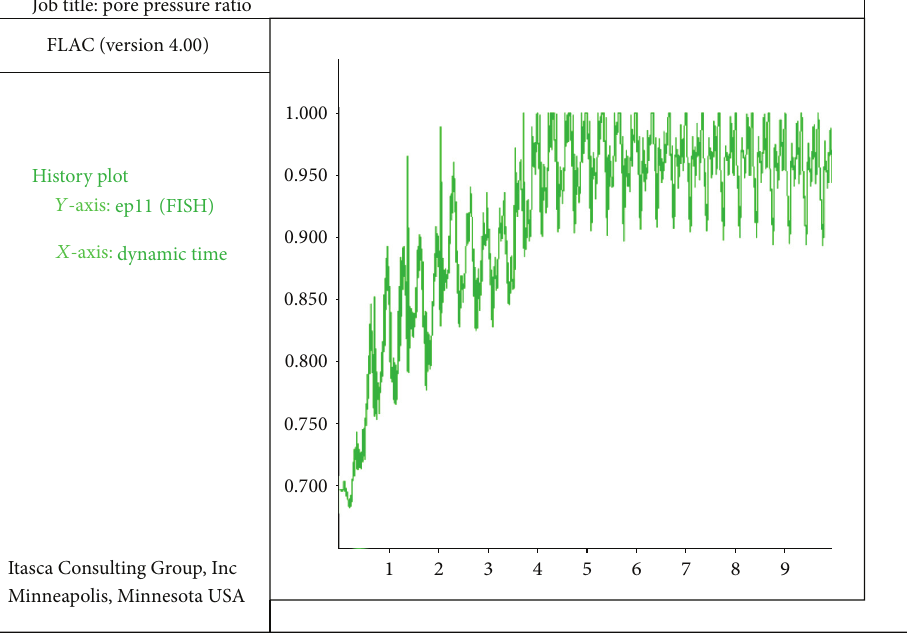
review of the models implies that the farther getting away from the quay wall, the greater excess pore water